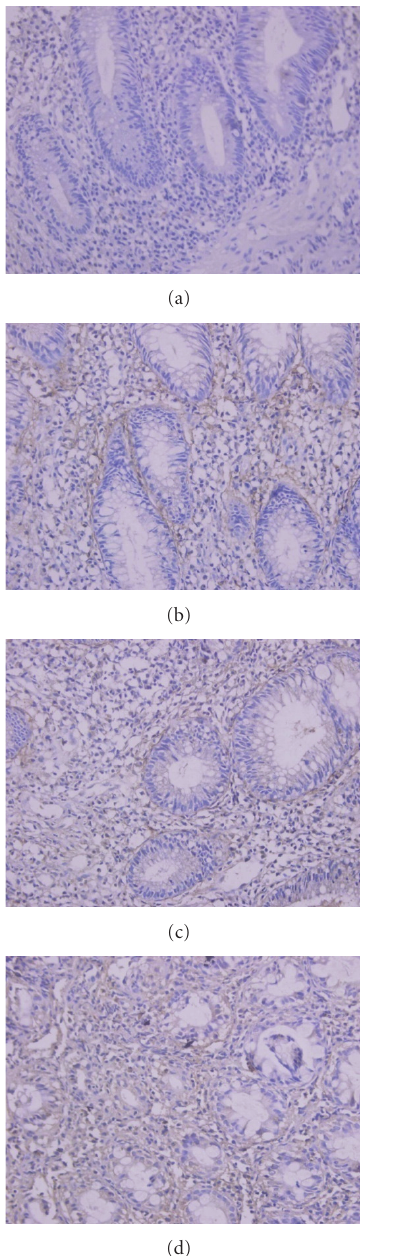
Figure 2: Immunohistochemistry showing MMP-1 expression in (a) control group, (b) M group, and (c, d) MTS group: M , mild; MTS, moderate-to-severe.